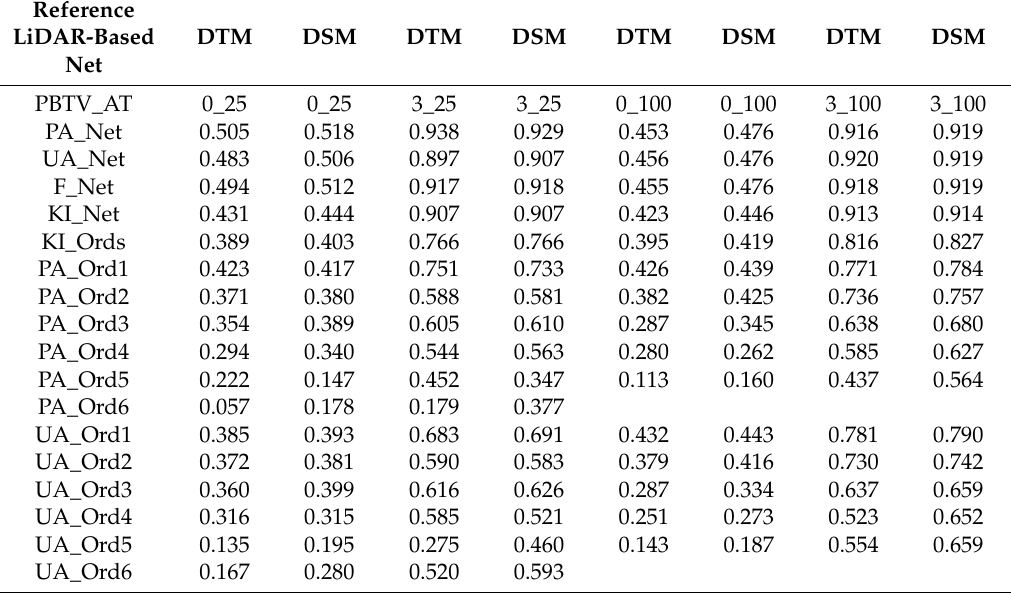
Table 5. Performance accuracy metrics computed based on a comparison between whole channel networks/orders extracted from the LiDAR DTM/DSM 28.5 m and the ALOS DSM 28.5 m at different ATs expressed in the corresponding number of pixels and PBTV in pixels.